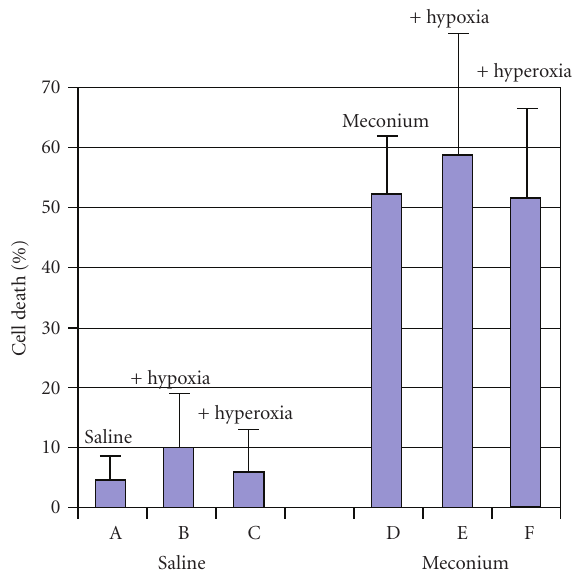
Figure 2: Cell death in A549 cell line studies. Percent of cell in saline- (A, B, C) or meconium- (D, E, F) treated A549 cells in presence of hypoxia (B, E) or hyperoxia (C, F). Meconium + hypoxia (E) or hyperoxia (F) demonstrated some increase in cell death compared to saline + hypoxia (B) or hyperoxia (C). P < . 05 meconium (D, E, F) versus saline (A, B,